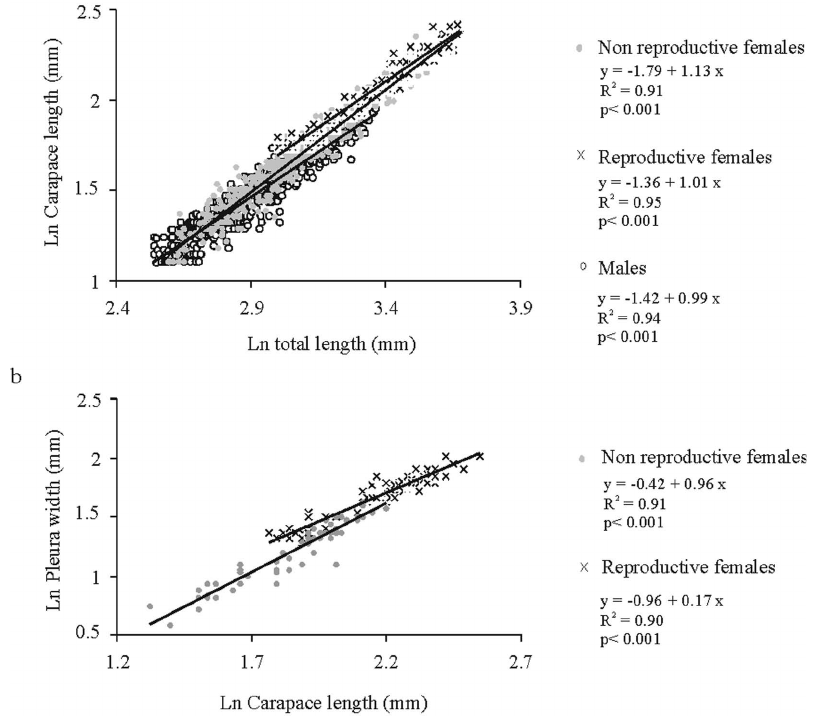
non-reproductive